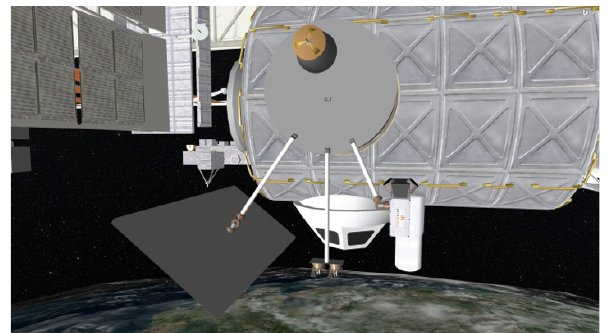
Figure 6. Close-up view of the Second-Generation